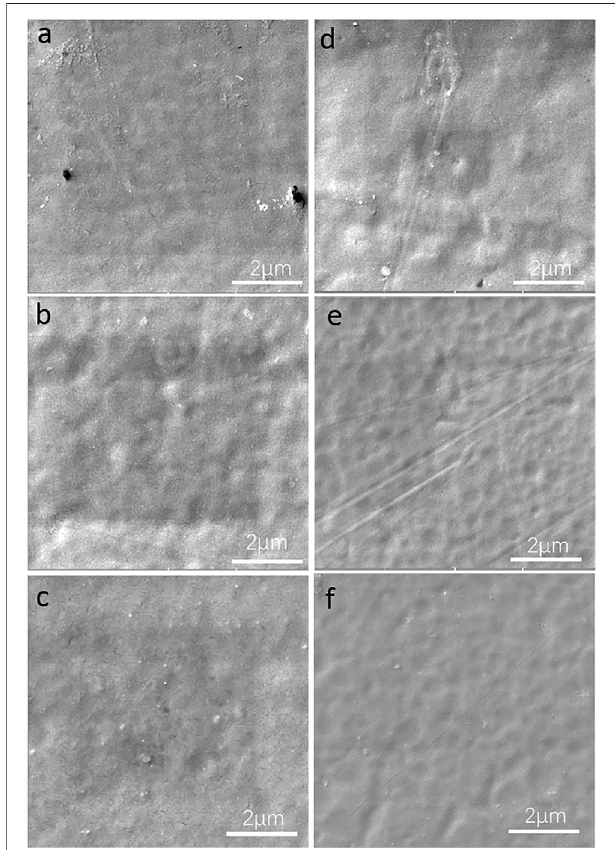
FIGURE 6 | Surface morphology of the WEP coating (control) and GOWE-0.1 coating (0.1 wt% GO) after the exposure in S. oneidensis culture for (A) 24 h, control (B) 96 h, control, and (C) 10 days, control; (D) 24 h, GOWE-0.1 coating; (E) 96 h, GOWE-0.1 coating, and (F) 10 days, GOWE-0.1 coating.